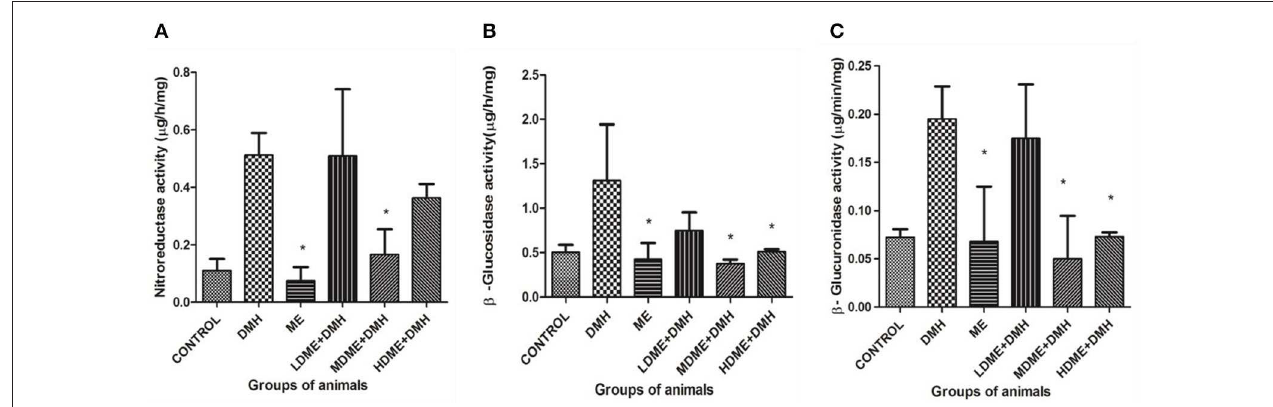
FIGURE 3 | Fecal enzymes activity in different groups of animals: (A) nitroreductase, (B) β -glucosidase, and (C) β -glucuronidase. Experiment was performed in triplicates. Values are expressed as mean ± SD. * p < 0.05 vs. 1,2-dimethylhydrazine (DMH)-treated.